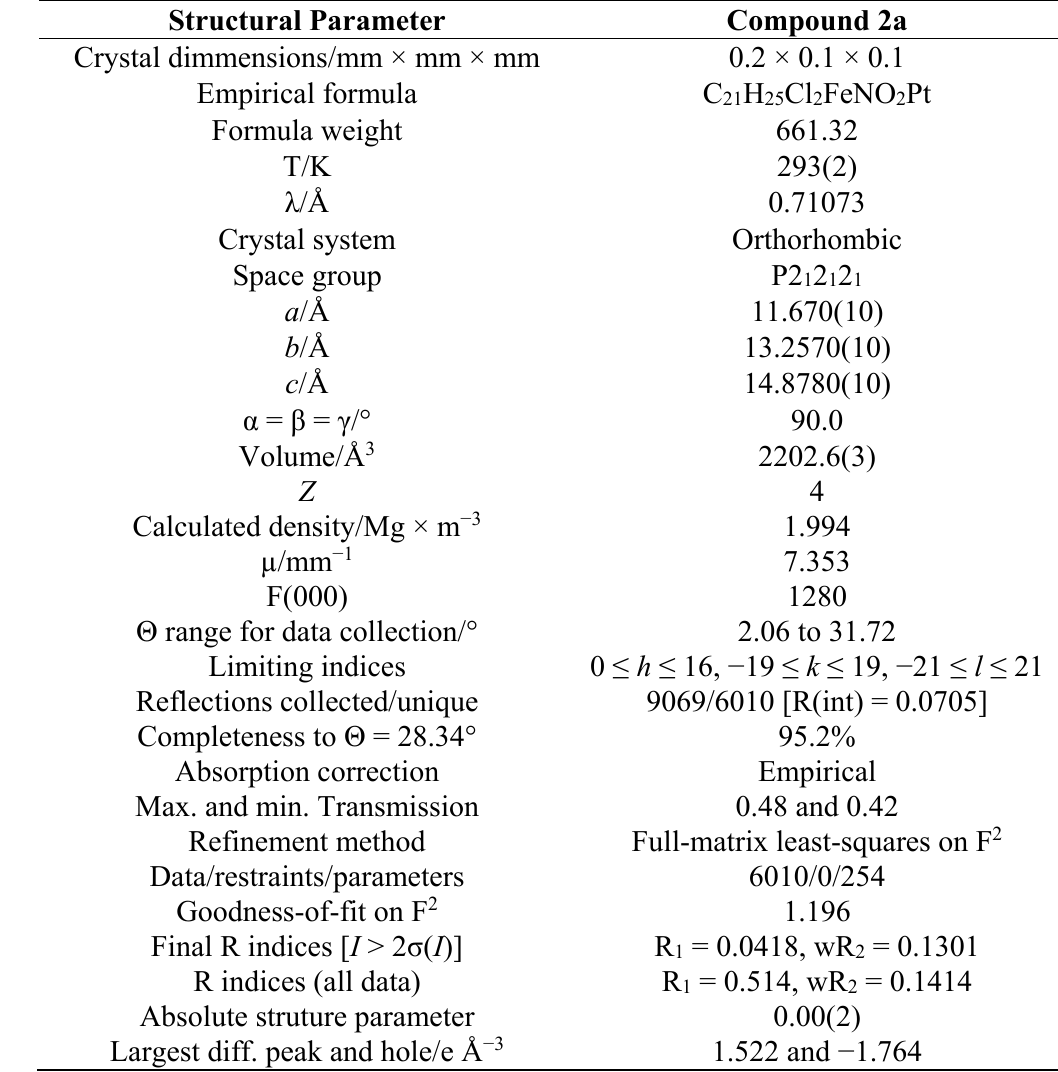
Table A1. Crystal data and structure refinement for trans- ( S C )-[Pt{ κ 1 -, N